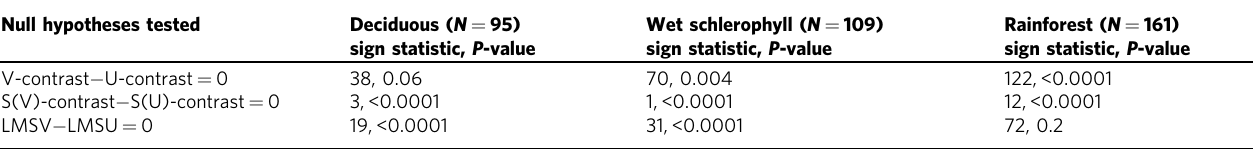
Table 2 Details of sign tests used to analyze data in Fig.